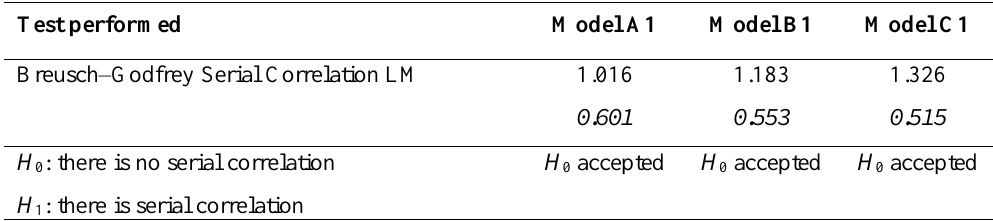
Table 6. Testing for